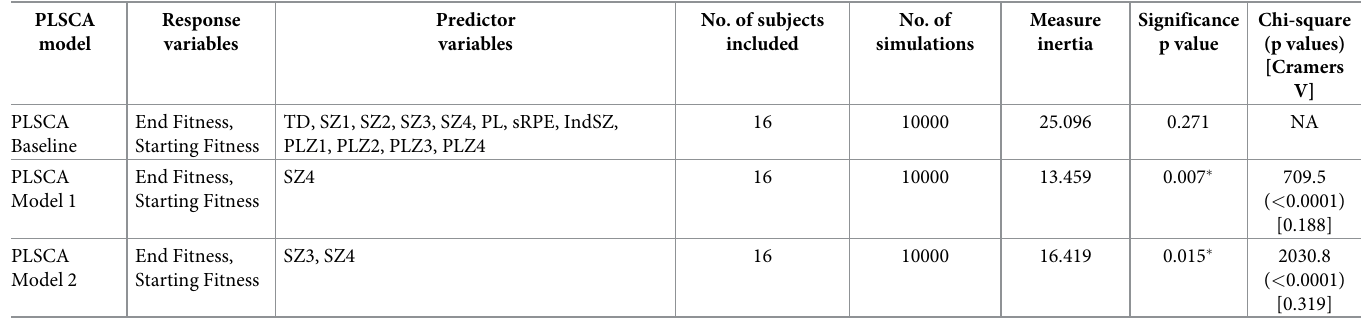
Table 6. Results of the PLSCA using refined models.